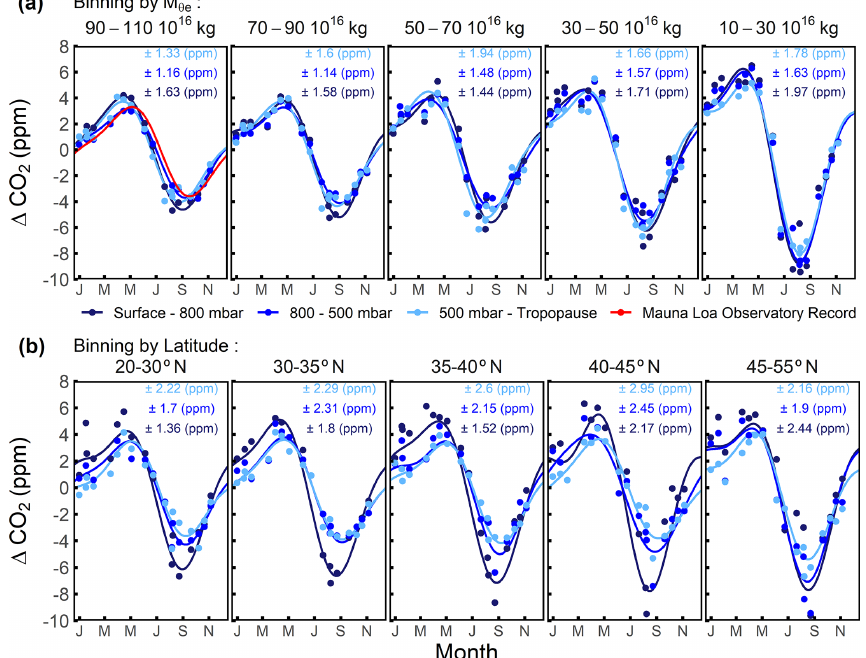
Figure 9. Seasonal cycles of airborne Northern Hemisphere CO 2 data sorted by (a) M θ –pressure bins and (b) latitude–pressure bins. M θ e e bins (10 16 kg) and latitude bins are shown at the top of each panel. Pressure bins are colored. The latitude bounds are chosen to approximate the meridional coverage of each corresponding M θ bin in the lower troposphere. The seasonal cycle at MLO from 2009 to 2018 is shown in e the 90–110 M θ bin panel, which spans the M θ of the station. Airborne observations are first grouped into M θ –pressure or latitude–pressure e e e bins and then averaged for each airborne campaign transect, shown as points. We filter out the points averaged from fewer than twenty 10s observations. The seasonal cycle of airborne data and MLO (2009–2018) are computed by a two-harmonic fit to the detrended time series. –pressure or latitude–pressure bin is labeled at the top of each panel. These 1 σ The 1 σ variability about the seasonal cycle fits for each M θ e values are based on the distribution of all binned observations (not shown), rather than on the distribution of average CO 2 of each bin and airborne campaign transect